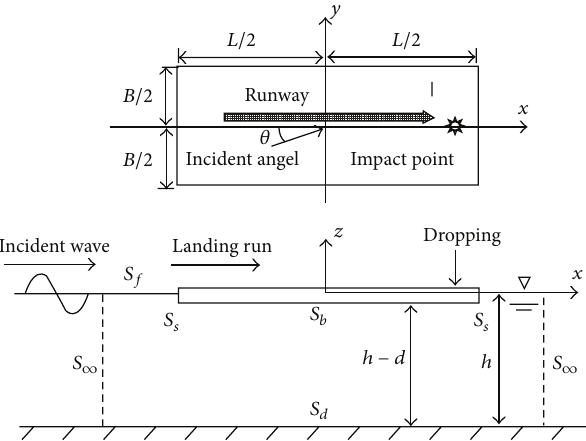
Figure 1: The fluid-structure system and coordinate